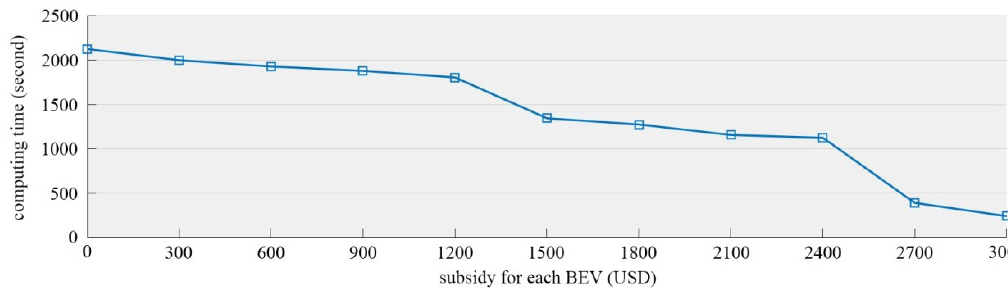
Energies 2018 , 11 , x FOR PEER REVIEW Figure 5. The results of the local search algorithm under different subsidies. Figure 5. The results of the local search algorithm under different subsidies.